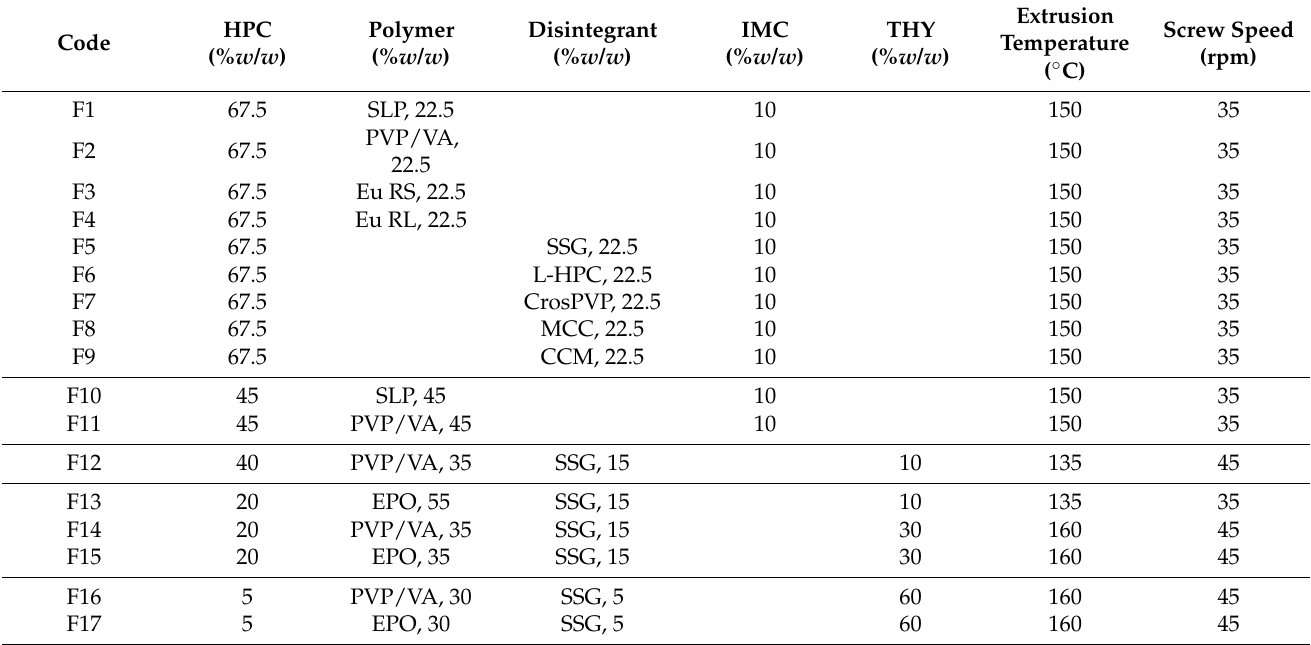
Table 1. Optimized filament formulations and extrusion